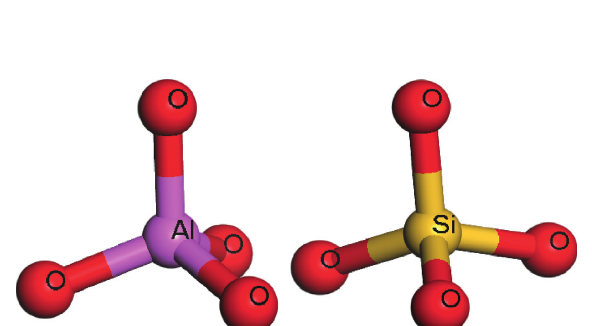
Figure 4: Structures of [AlO